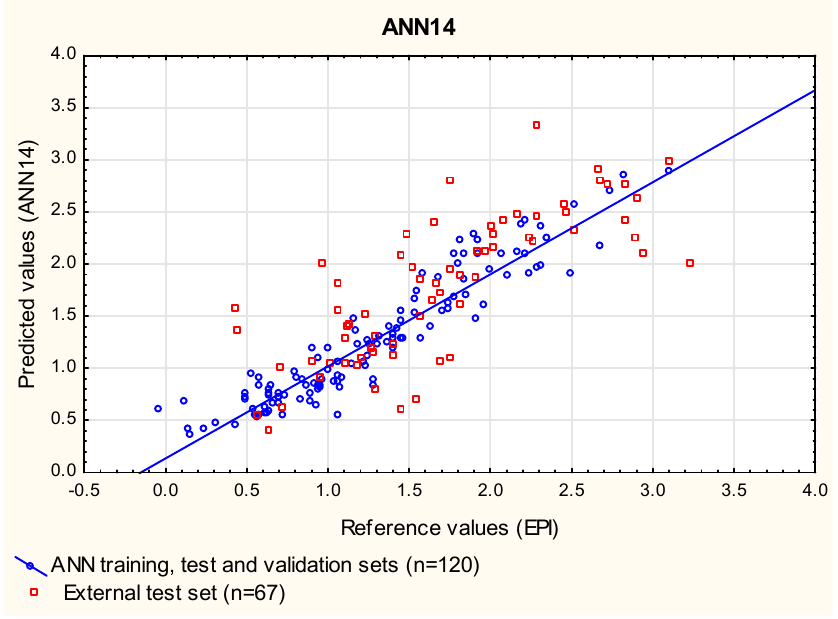
Figure 6. ANN14 model—predicted vs. reference log BCF values.